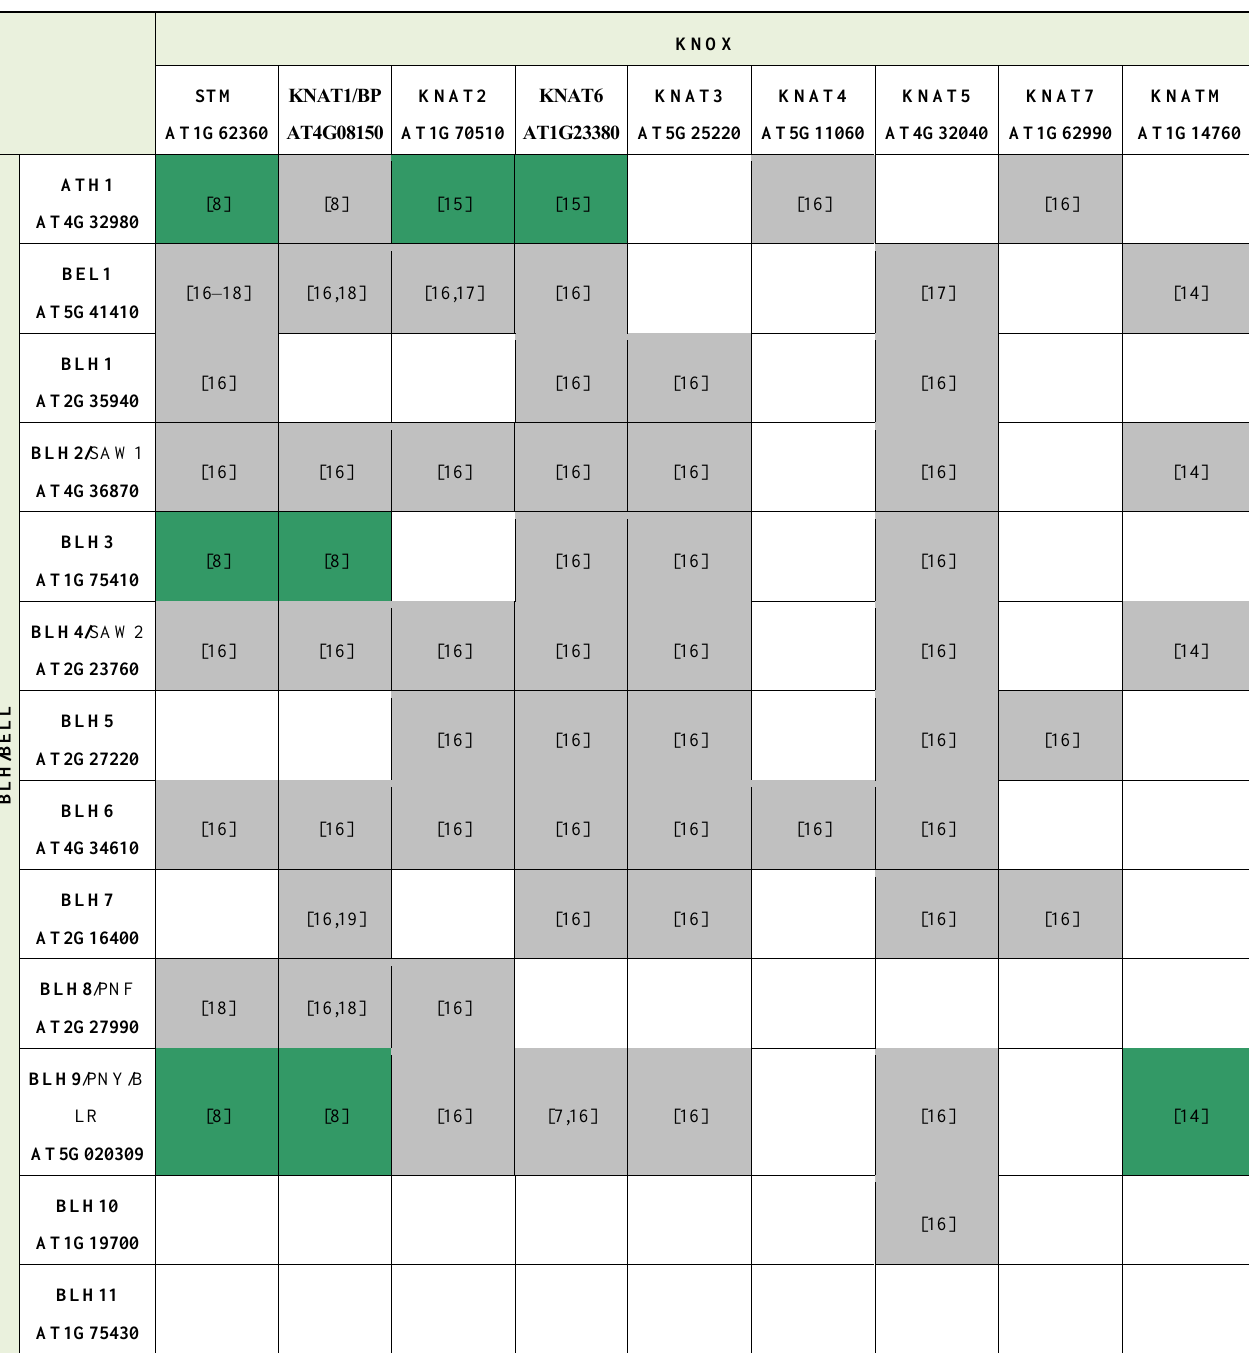
Table 1. Interaction between A. thaliana KNOX and BLH proteins. KNOTTED1-LIKE homeobox (KNOX) proteins are indicated in rows and BEL1-like homeobox (BLH) proteins in columns with corresponding gene ID numbers. Interaction data deriving from both low and high throughput two-hybrid screens are indicated in grey, interactions that were confirmed in planta are highlighted in